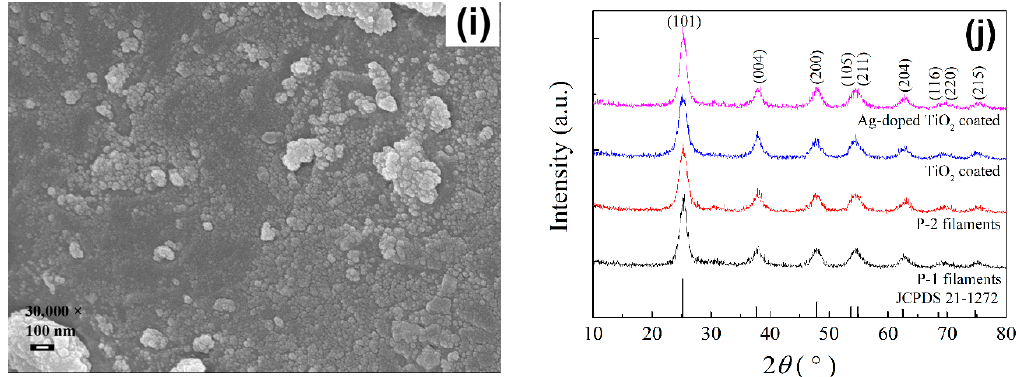
Figure 1. The field emission scanning electron microscope (FESEM) images for the ( a ) pristine filaments, 1000×; ( b ) P – 1 filaments, 1000×; ( c ) P – 1 filaments, 30,000×; ( d ) P – 2 filaments, 1000× and ( e ) P – 2 filaments, 30,000×; ( f ) TiO 2 coated filaments, 1000× and ( g ) TiO 2 coated filaments, 30,000×; ( h ) Ag-doped TiO 2 coated filaments, 1000× and ( i ) Ag-doped TiO 2 coated filaments, 30,000×; ( j ) X-ray di ff raction (XRD)